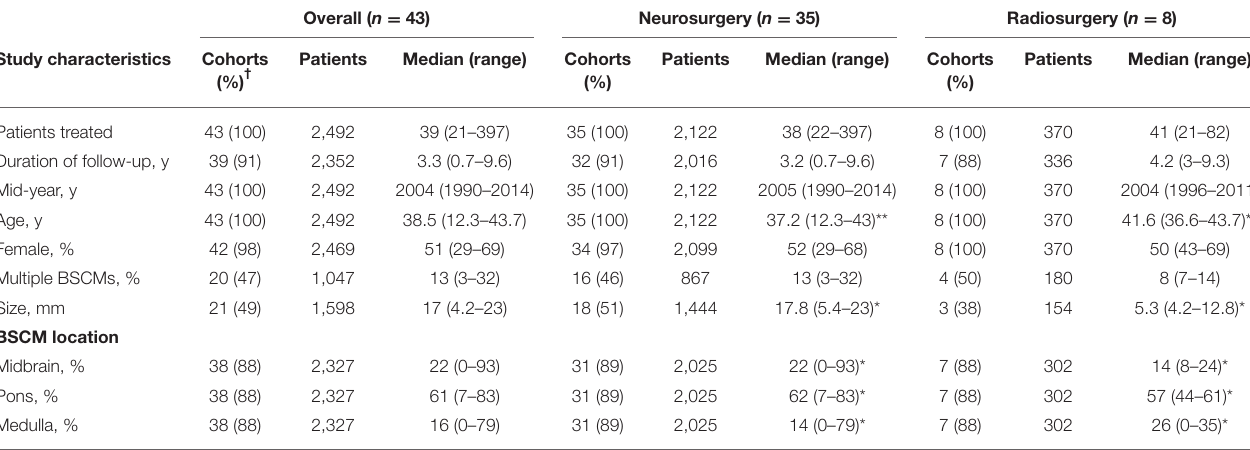
TABLE 2 | Characteristics of the included cohorts.